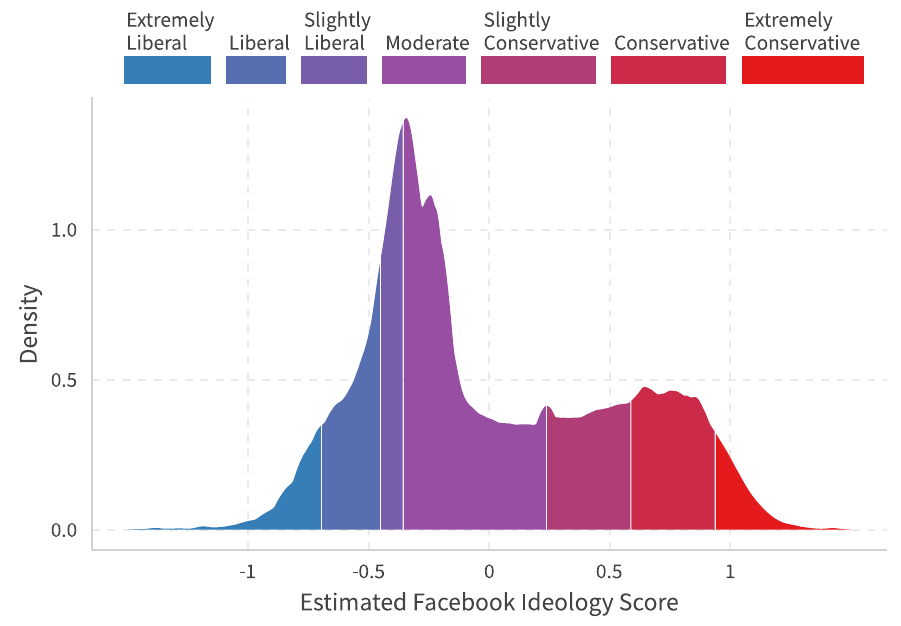
Fig 7. Density for all US users and self-report ideology shares in GSS. Colors represent matching densities with self- reported ideology shares in 2016 General Social Surveys [12]. US users are defined by any user that at least reacted to any national politicians’ (Sen, Rep, Gov) post once in 2015 and 2016, and we guess user’s location by the maximum national politician they liked in that state. We remove a huge jump created by users only like one and only one page: Arnold Schwarzenegger. We then sample users by 2016 population in each state [23] if that state is overrepresented in our sample relative to the